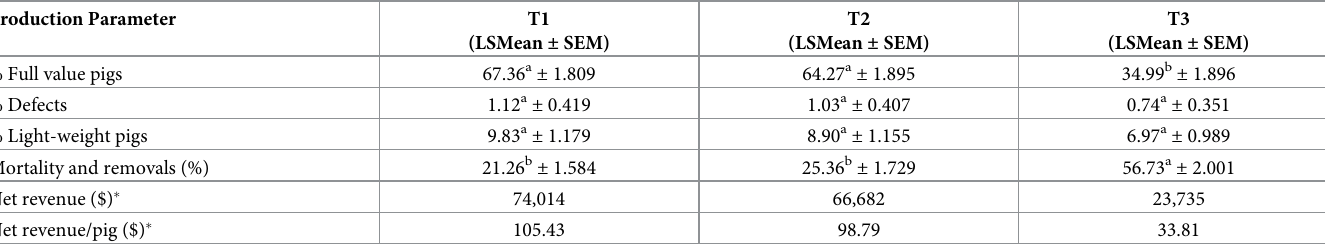
The feed concentrations of AB agents fed to group T1 were within label specifications for chlortetracycline (CTC, 400 g/ton), Denagard (35 g/ton), Aureomycin (400 g/ton) and BMD (30 g/ton). The concentration of CTC and sulfamethazine ( < 2.0 g/ton) in Aureomix S fed to group T1 was less than label specifications (100 g/ton for each ingredient). All samples fed to Table 3. Final market results for litters raised using a standard (T1) or modified (T2) antibiotic medication or an antibiotic-free (T3) production protocol. Production